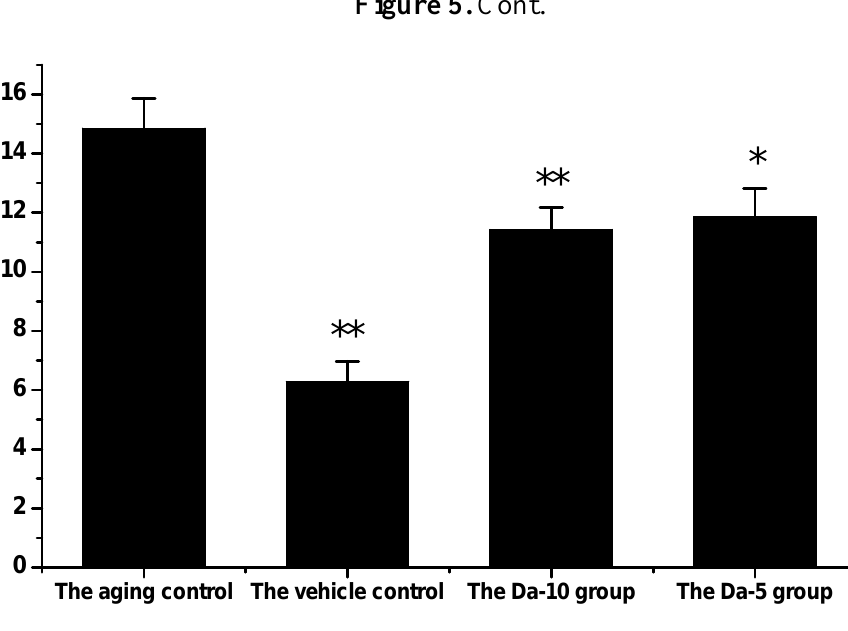
The aging control The vehicle control The Da-10 group The Da-5